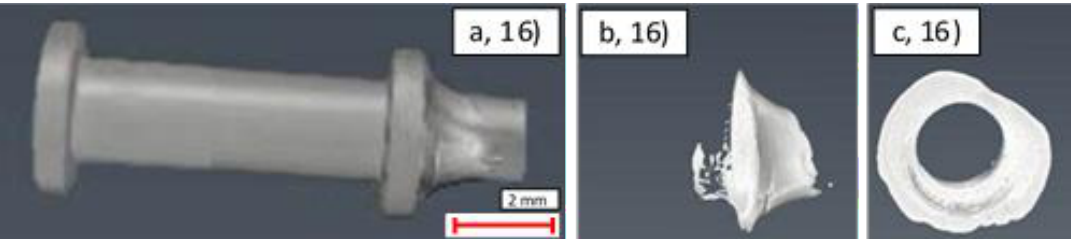
Figure 20. CT images of uncoated sample (16): ( a ) side view of gland exterior; ( b ) side view of interior solder; ( c ) axial view of interior solder.